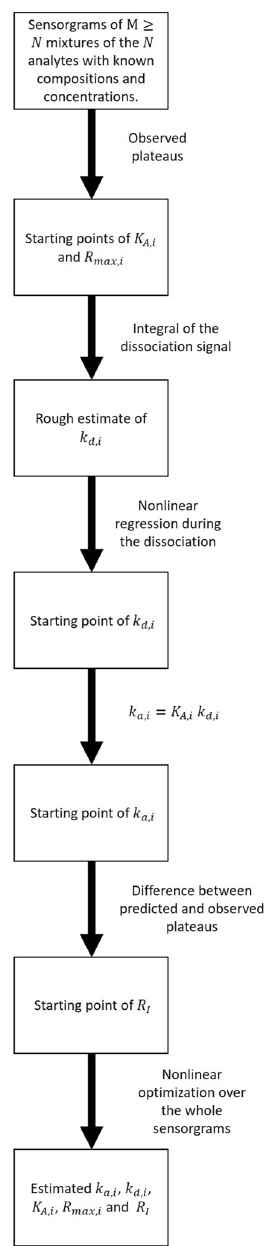
Figure 1. Algorithm for the estimation of the kinetic parameters of N analytes. The algorithm starts by providing a legitimate starting point for a nonlinear optimization routine over the dissociation phase before a second optimization routine over the whole sensorgrams leads to the final estimates. Estimates of k a , i , k d , i and R max i = 1, . . . , N can be obtained from SPR sensorgrams of M mixtures of the N analytes ( M ≥ N ) . The fit , i for is said ‘global–global’ as sensorgrams corresponding to different overall concentrations and different mixtures are used simultaneously in the fitting